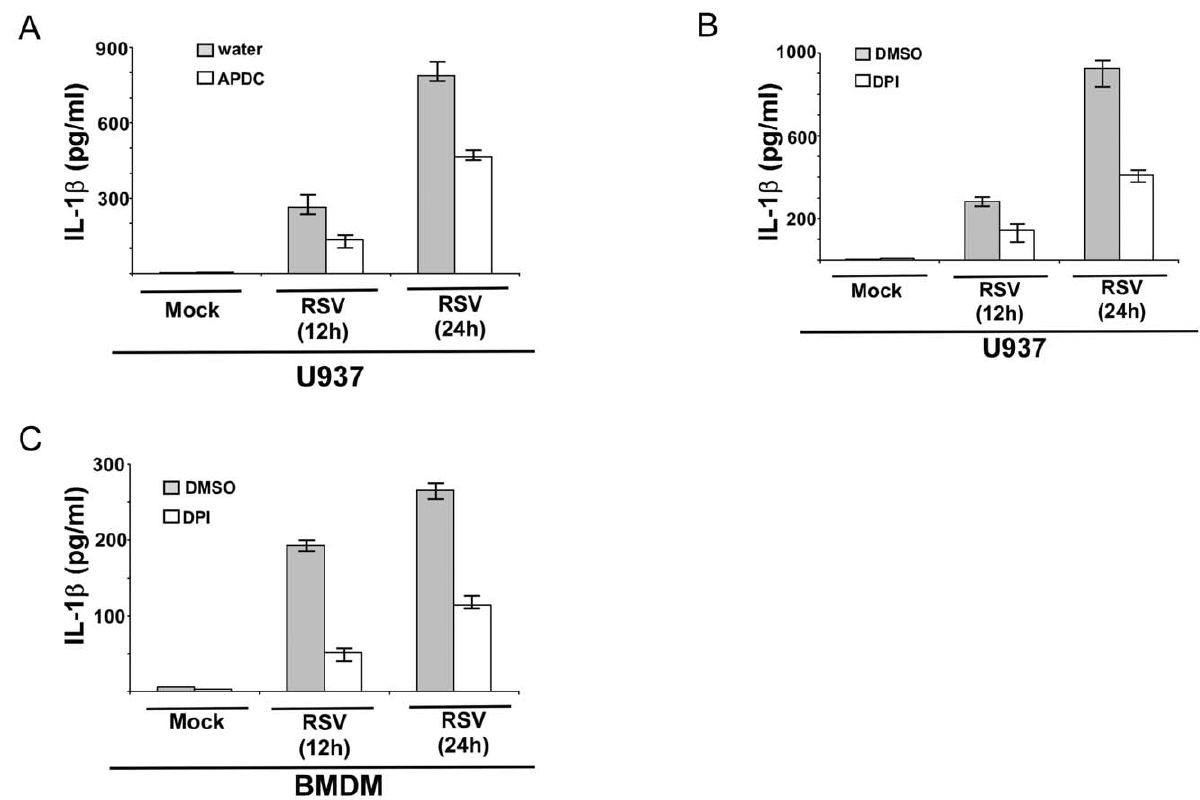
Figure 7. ROS produced during RSV infection triggers IL-1 b secretion. ( A ) U937 cells were infected with RSV (1 MOI) in the presence of ROS inhibitor APDC (50 m M). Water served as the vehicle control. IL-1 b levels in the medium supernatant were assayed by ELISA at 12 h and 24 h post- infection. ( B ) U937 cells were infected with RSV (1 MOI) in the presence of ROS inhibitor DPI (10 m M). DMSO served as the vehicle control. IL-1 b levels in the medium supernatant were assayed by ELISA at 12 h and 24 h post-infection. ( C ) Wild type primary mouse bone marrow derived macrophages (BMDM) were infected with RSV (1 MOI) in the presence of ROS inhibitor DPI (2 m M) or DMSO (vehicle control). IL-1 b levels in the medium supernatant were assayed by ELISA at 12 h and 24 h post-infection. Each value represents the mean 6 standard deviation from three independent